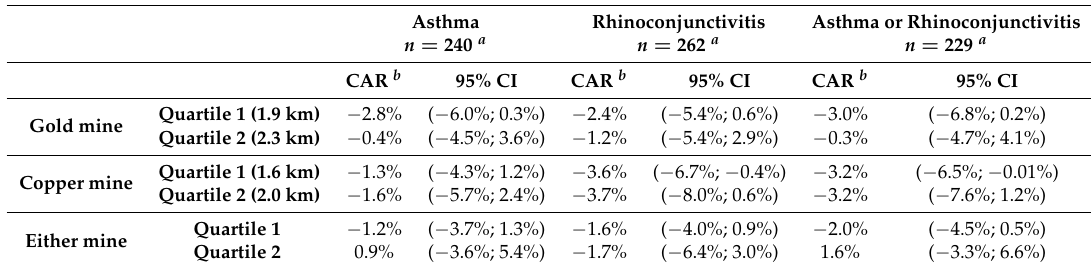
Table A1. Estimated causal attributable risk (CAR) of respiratory diseases in children, expressed as percentage points with the 95% confidence intervals (95% CI) including schools as a potential confounder. Data from children living in a rural mining community in the north of Chile, 2009.